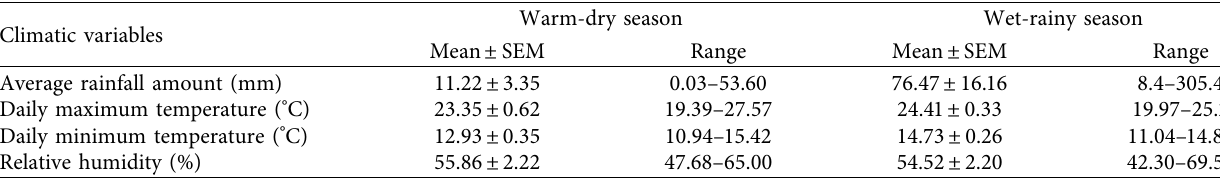
Table 4: Mean ± SEM and range of selected climatic variables collected during field survey conducted from October 2021 to May 2022 in Kajiado County.